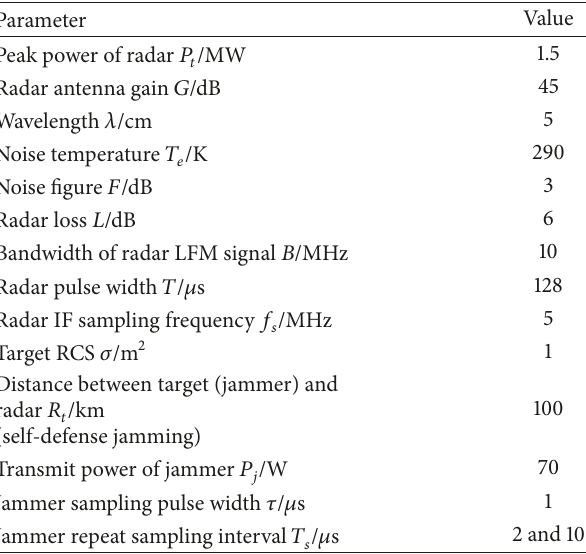
Table 1: Simulation